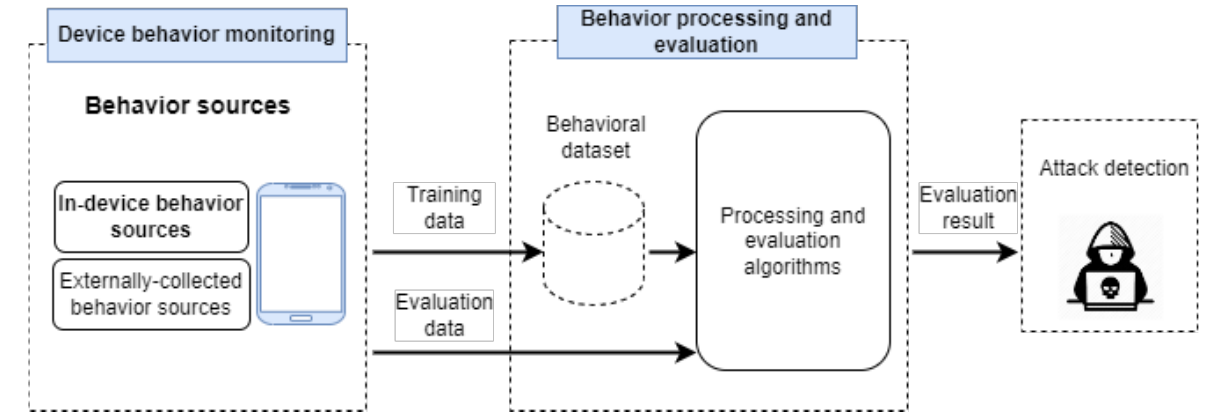
Figure 2. Common device behavior solutions life cycle.